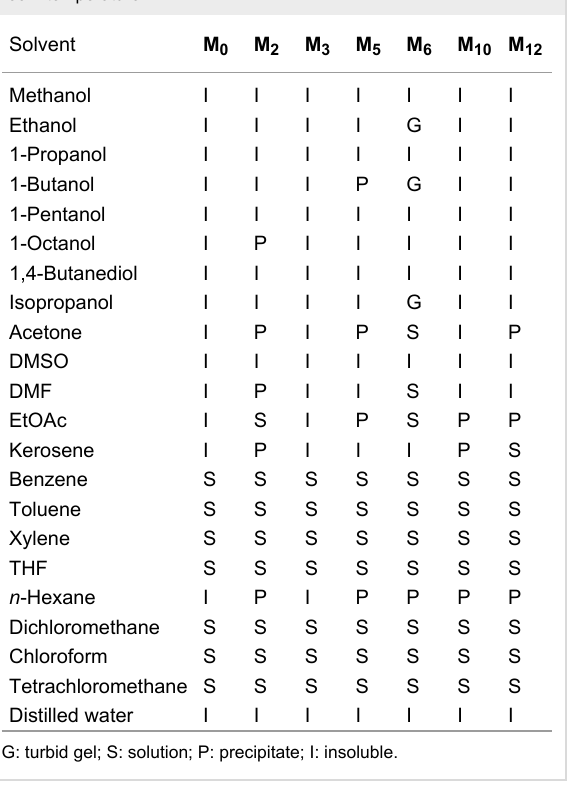
Table 2: Gelation performances of the seven cholesteryl derivatives at room